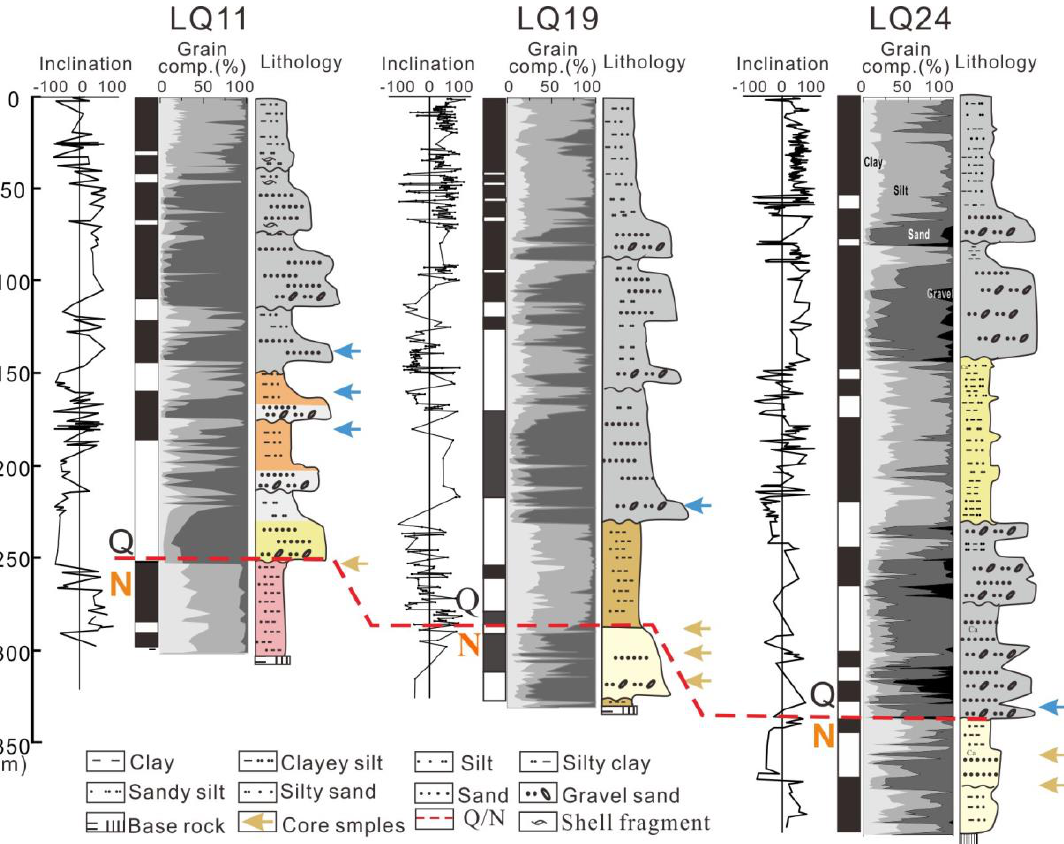
Figure 2. Sediment sampling depth and stratigraphy of Cores LQ11, LQ19, and LQ24. Comprehensive stratigraphic information on the strata of the Yangtze Delta includes sedimentary facies, polarity epoch, and sediment composition. Q = Quaternary, N = Pliocene. The red dotted line represents the Pliocene-Pleistocene boundary. Logs of LQ11, LQ19, and LQ24 are modified after [23], [22], and [27], respectively.